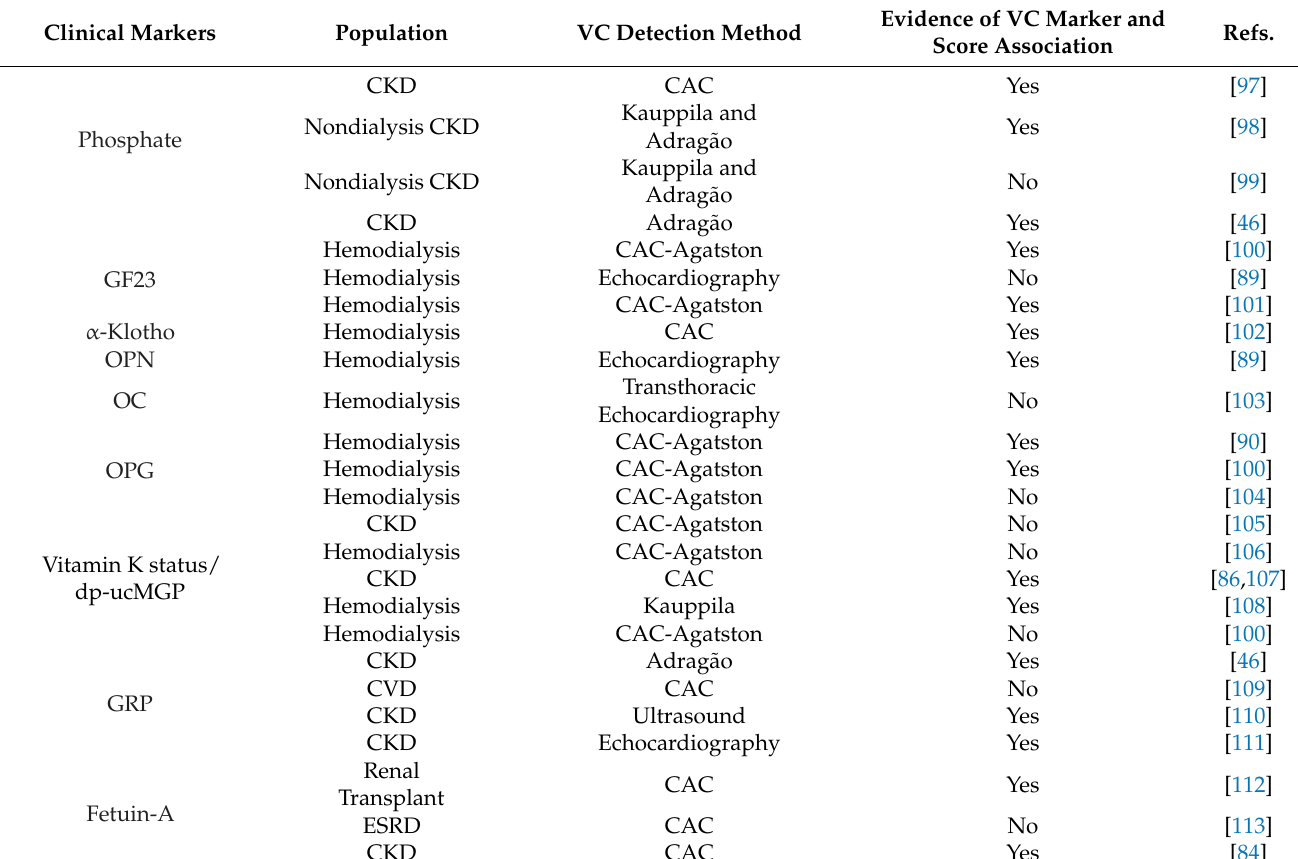
Table 3. Vascular Calcification Players and their Correlation with Calcification Scores from CKD Clinical